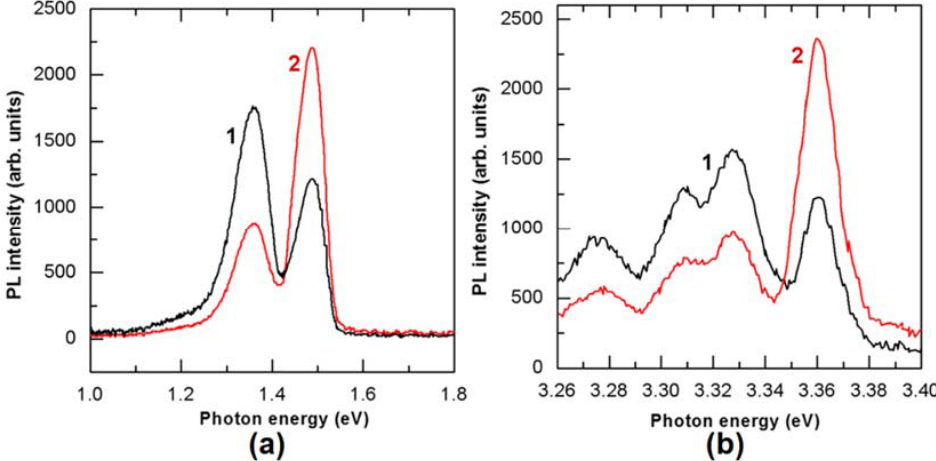
Figure 6. PL spectra of the GaAs core ( a ) and ZnO shell ( b ) measured at 10 K with the emission polarized along the nanowire axis (curve 1), and polarized in the radial direction (curve 2).